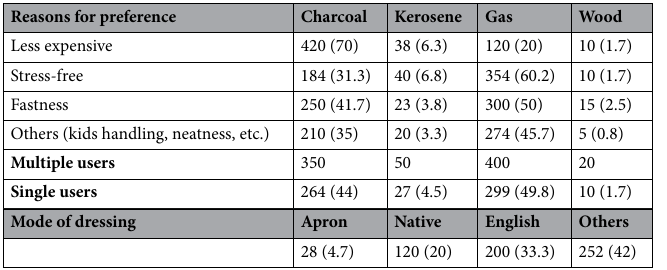
Table 2. Cooking attributes of respondents. Bracketed figures represent the percentages of each figure (frequencies) beside them.